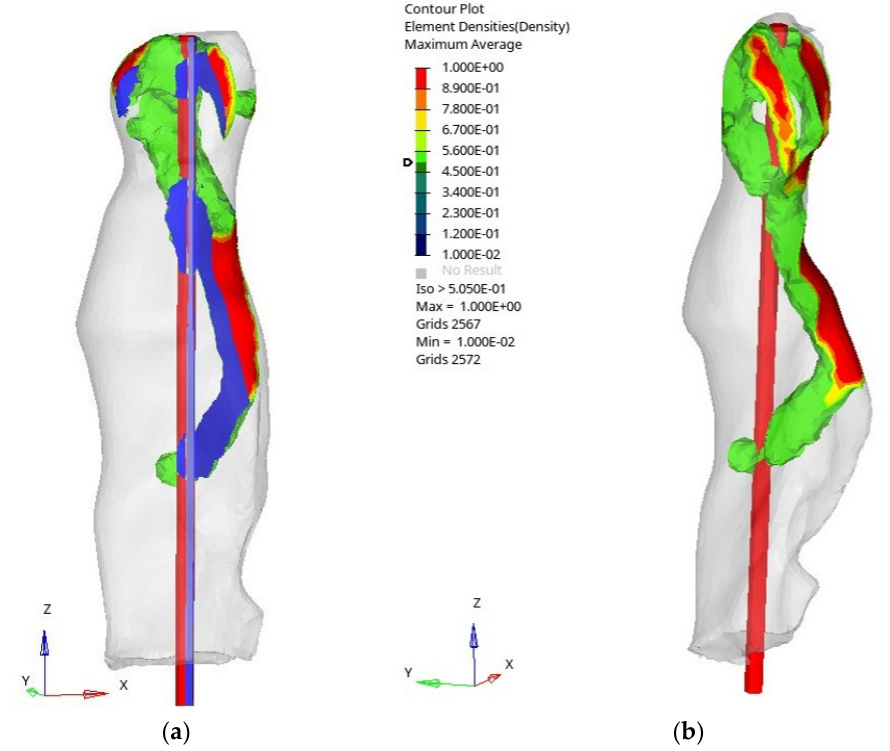
Figure 10. Design variant: ( a ) section cut (in blue); ( b ) density distribution.